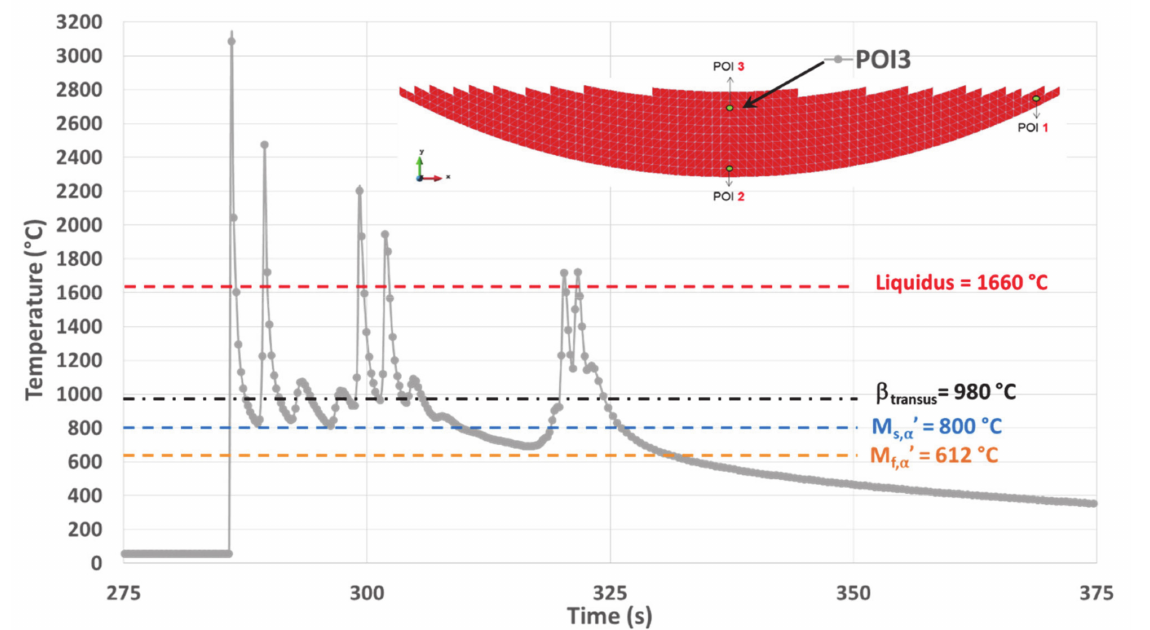
Figure 12. Simulated thermal history of POI3, starting from the material deposition up to the final